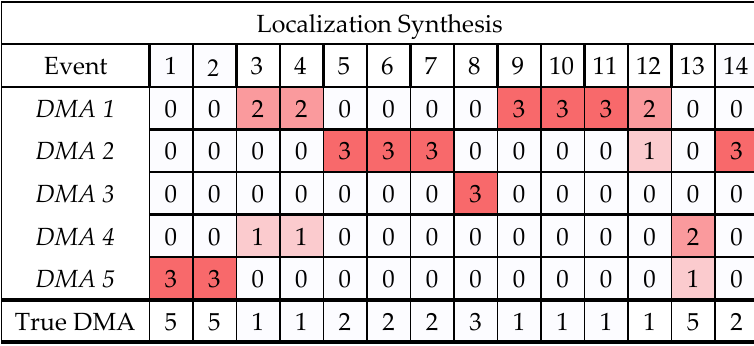
Figure 9. Events localization by aggregated votes from WSA, WTA, and BSA modules in the C-town case study.